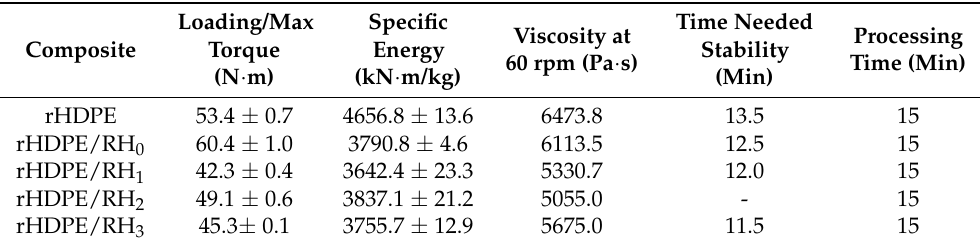
Figure 6. Fusion curves: ( a ) stock temperature vs. time and ( b ) torque vs. time for neat rHDPE and reinforced composites. Table 3. Fusion behavior for neat and filled rHDPE.